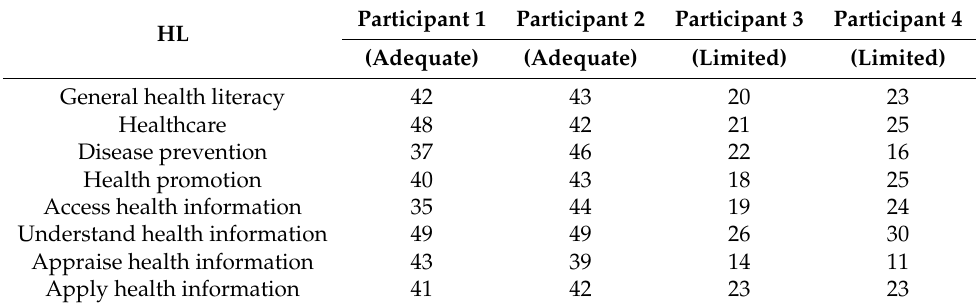
Overall scores (0–50) of the participants in the European Health Literacy Survey Questionnaire